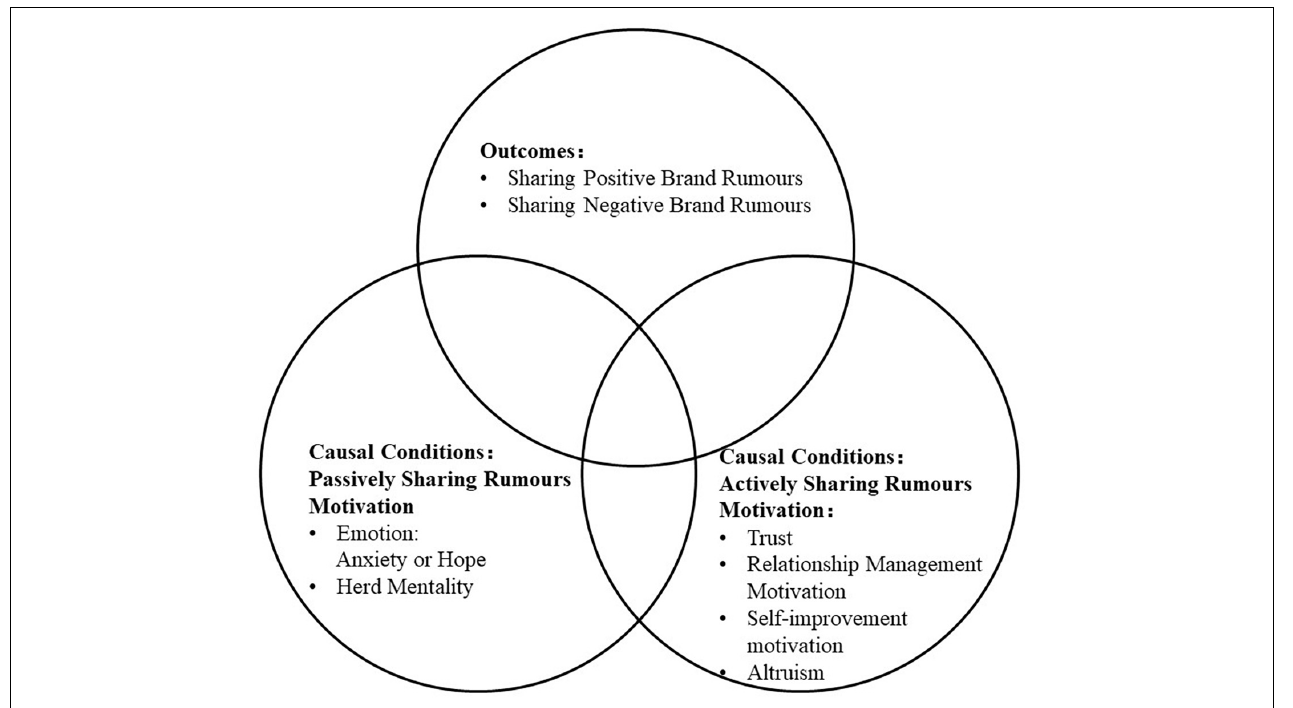
FIGURE 1 | The conceptual model of sharing positive or negative brand